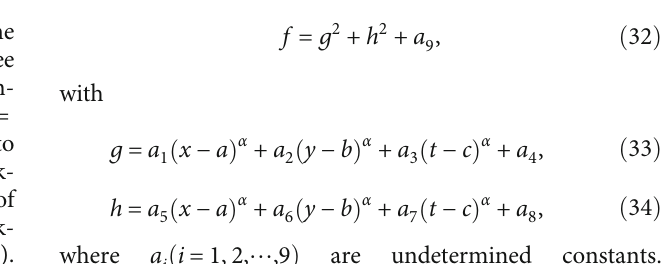
Figure 14: 3-in-2-out-type interaction in the fractional line three-soliton solution u with α = 83/99 , a = 0 , b = 0 , c = 0 , k p 1 = − 1/3 , p 2 = − 2/3 , p 3 = − 5/3 , σ = 1 , ξ ð